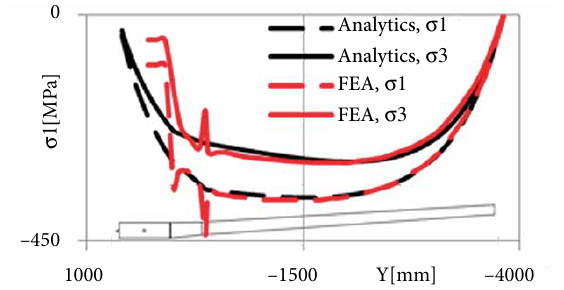
Fig. 6. Comparison of σ 1 solution, Loading A , Step 1